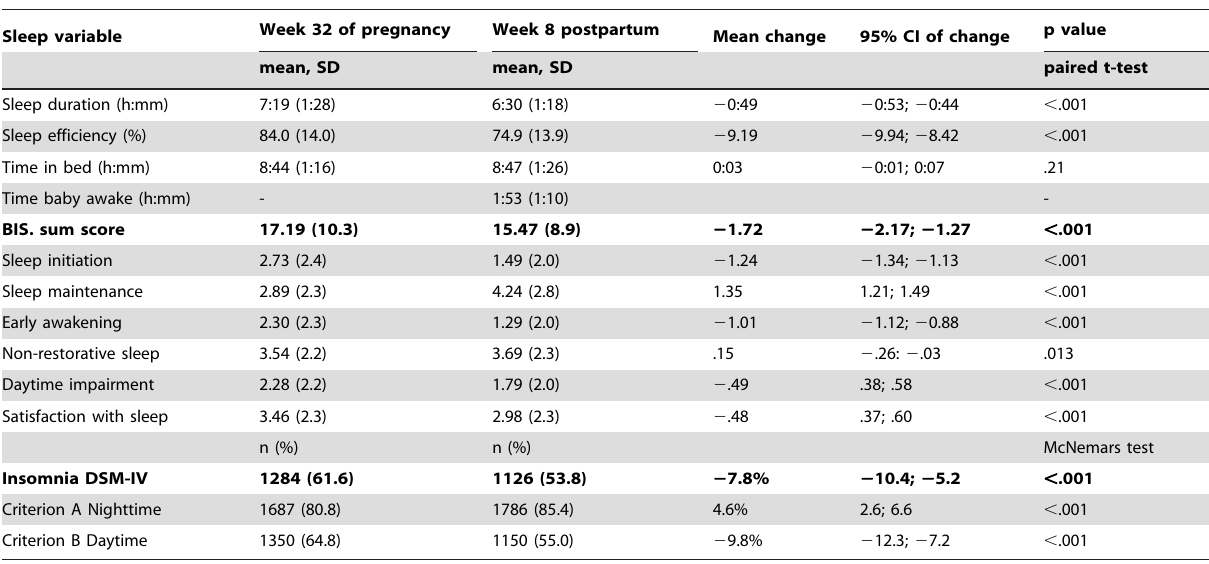
Table 1. Sleep before and after delivery among 2088